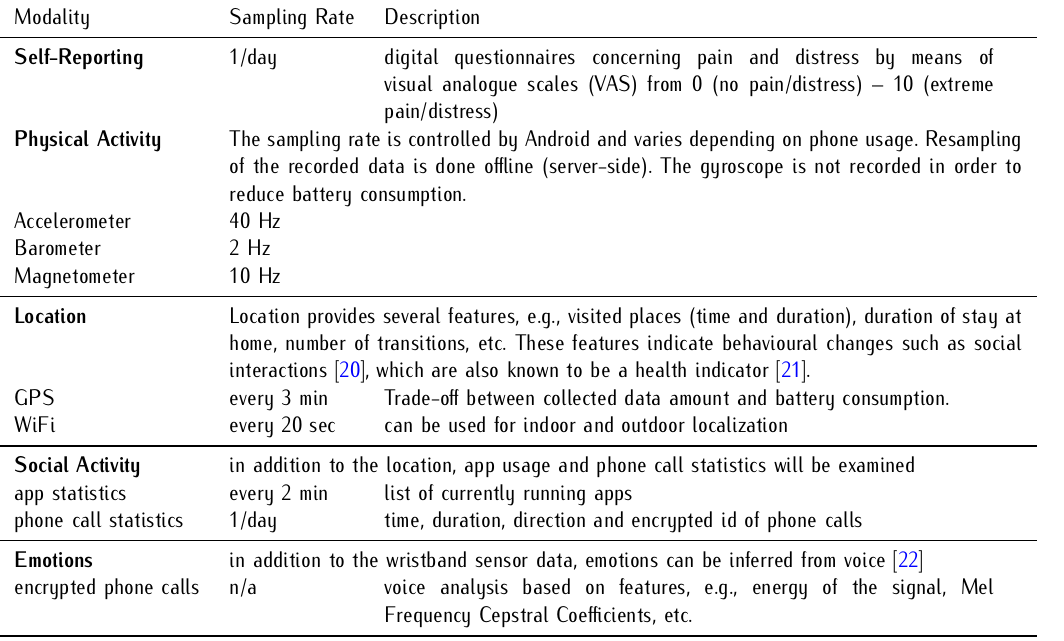
Table 1. Recorded smart-phone data, grouped by the measurement goals self-reporting, physical activity, location and social activity